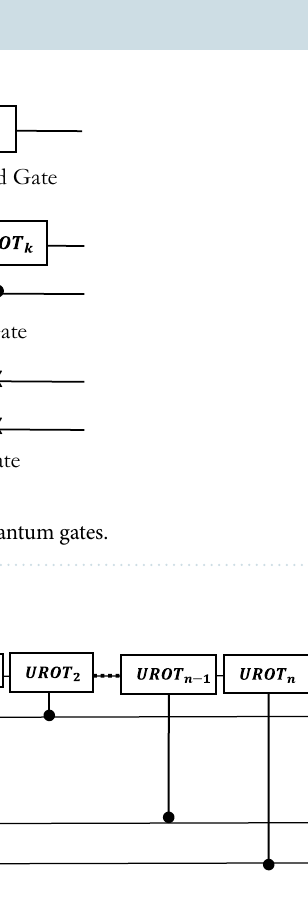
Figure 3. Circuit for a quantum Fourier